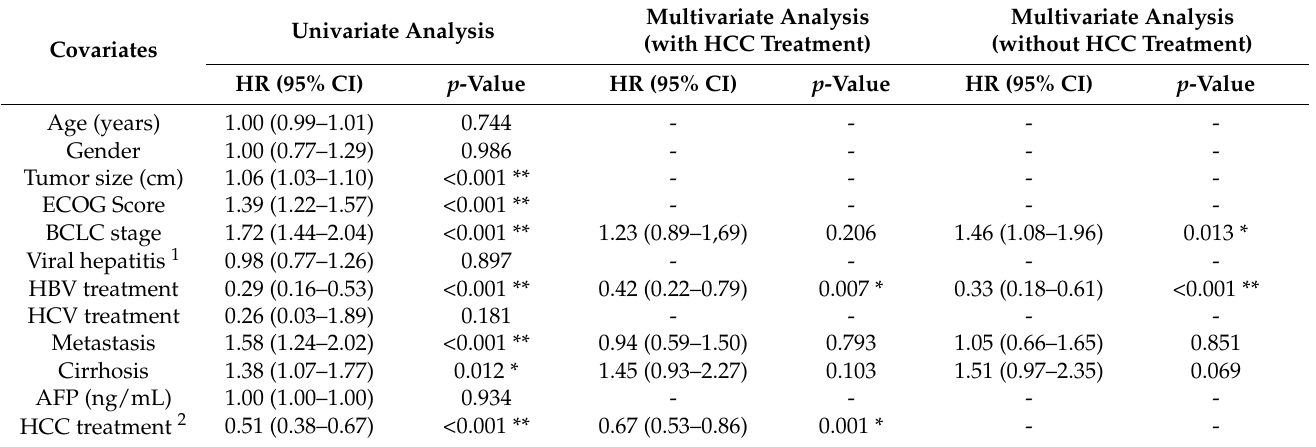
Figure 2. Kaplan – Meier survival curve for Ethiopian HCC patients. The red dotted-lines indicate Figure 2. Kaplan–Meier survival curve for Ethiopian HCC patients. The red dotted-lines indicate the 1-year survival probability. Censored subjects are d esignated as “+” mark and represent those the 1-year survival probability. Censored subjects are designated as “+” mark and represent those patients who were lost during follow-up or alive at the end of the study. patients who were lost during follow-up or alive at the end of the study. Table 4. Univariate and multivariate analysis of factors associated with survival of HCC